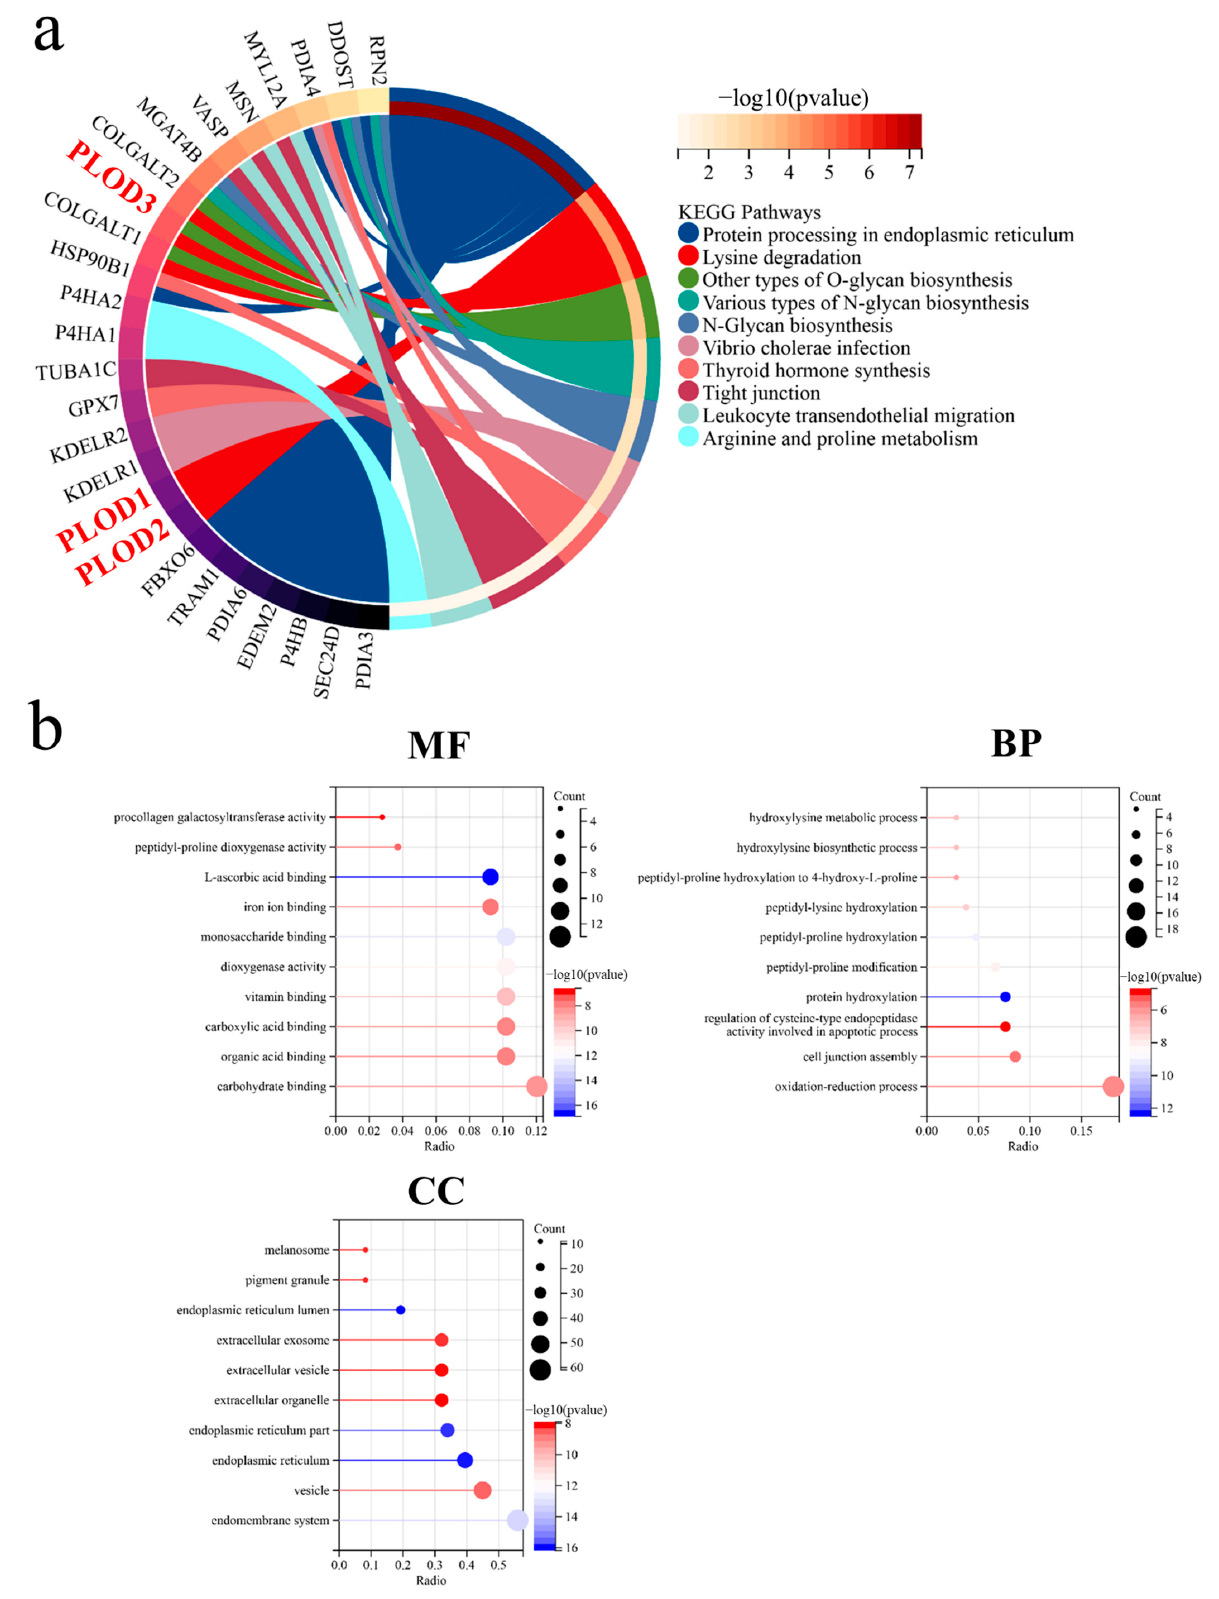
Figure 4. The PLOD family members’ genes enrichment analysis in STS. ( a ) KEGG pathway analysis and ( b ) GO enrichment analysis including molecular function (MF), biological process (BP), and cellular component